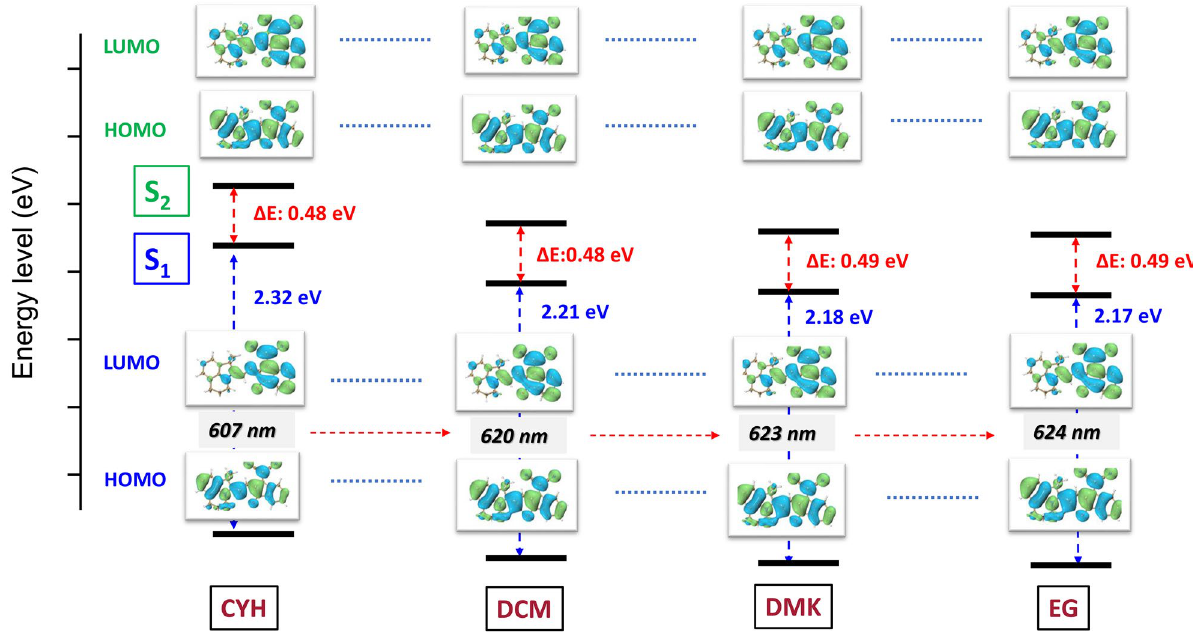
Figure 4. Quantum chemistry calculations. The calculated energy levels of first and second excited states, S 1 and S 2 . The associated HOMO/LUMO orbitals are presented. A clear solvatochromic effect can be seen in calculated HOMO to LUMO